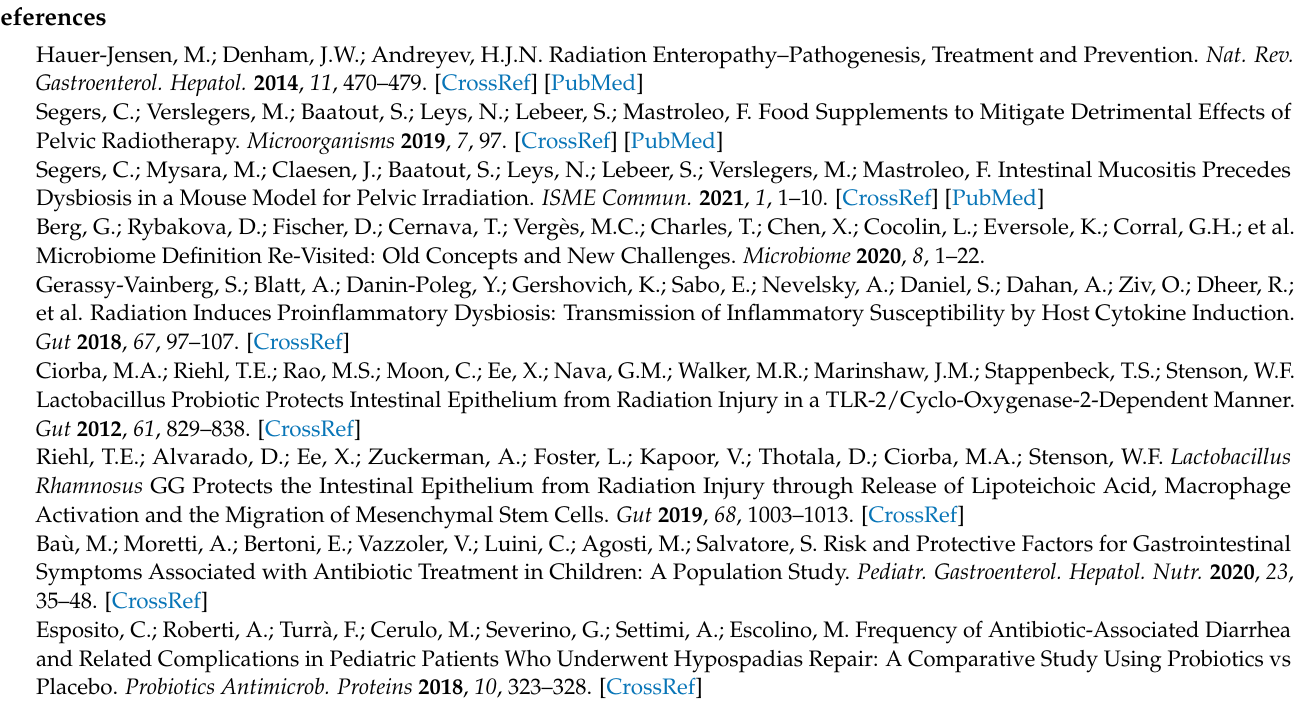
the samples; Figure S3: Changes in alpha diversity index Shannon; Figure S4: Changes in alpha diversity index Shannon even, considering solely evenness, following (sham-)irradiation; Figure S5: Unweighted UniFrac NMDS plots; Figure S6: Heatmap representing the relative abundance of significant gut microbial dysbiosis markers detected in saline-given mice following sham-irradiation; Figure S7: Heatmap representing the relative abundance of significant gut microbial dysbiosis markers detected in saline-given mice following pelvic irradiation; Table S1: p values of conditional unweighted UniFrac beta diversity analyses by AMOVA; Table S2: Differential OTUs detected in saline-given mice following sham-irradiation; Table S3: Differential OTUs detected in saline-given mice following pelvic